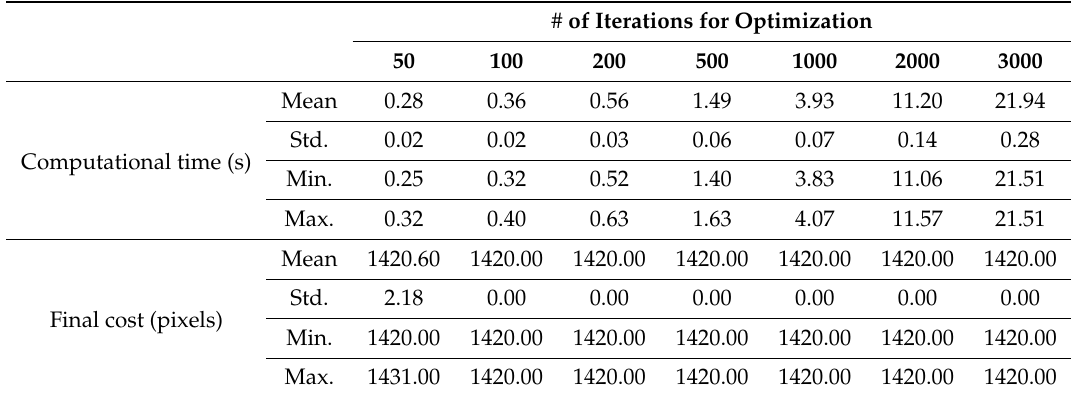
Table 3. Hierarchical path-planning using the pre-built map; 3000 iterations.